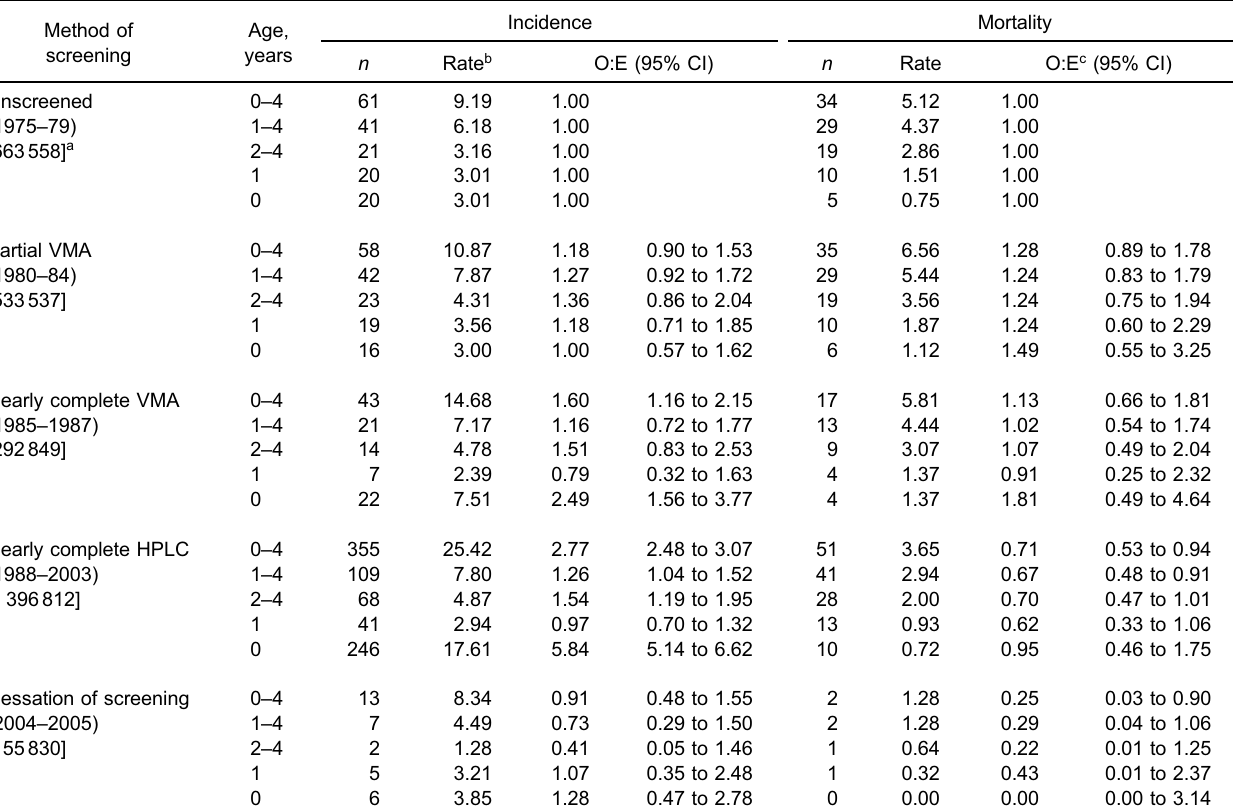
Table 2. Incidence and mortality of neuroblastoma by birth cohort in Osaka, 1975 – 2009 Method of